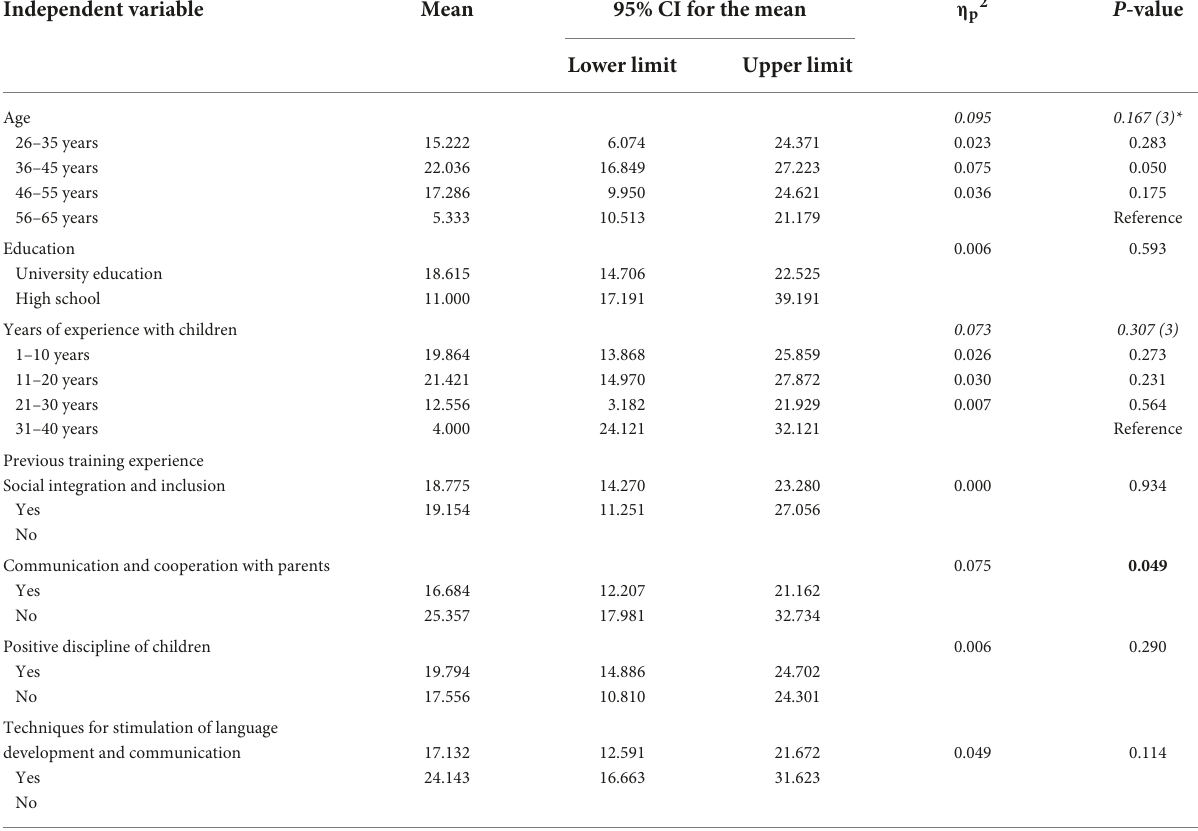
TABLE 3 The impact of training sessions on overall self-efficacy scores: Mean values of pre-post-test differences in the general linear model. Independent